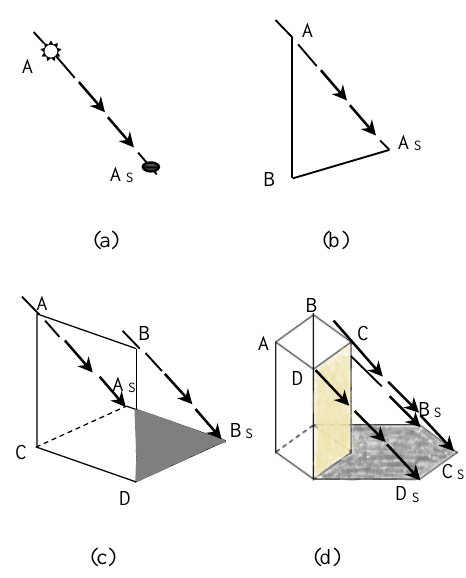
Figure 2. Shadow progressions, (a) Shadow of a point, (b) Shadow of a line, (c) Shadow of plane, (d) Shadow of a